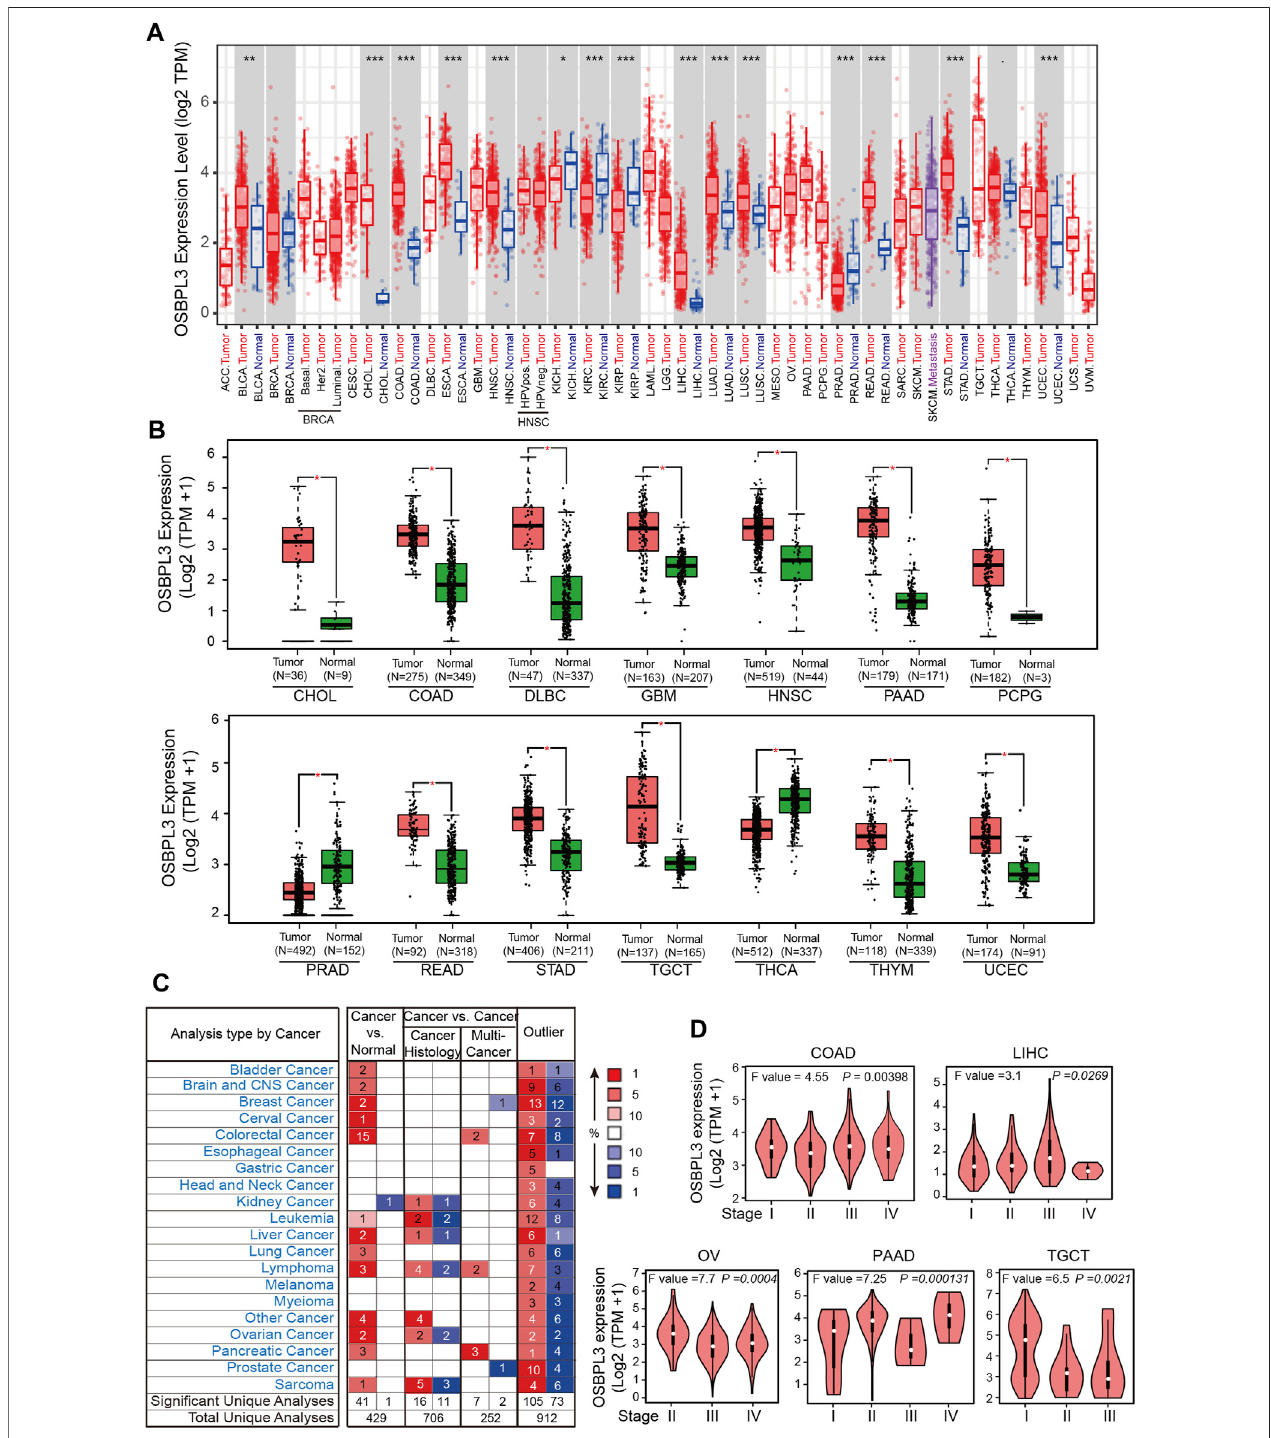
FIGURE 1 | Expression level of the OSBPL3 gene in different tumors and pathological stages. (A) Expression status of the OSBPL3 gene across diverse cancers from the TCGA dataset in TIMER. (B) Expression of OSBPL3 in the cancers from the TCGA project and the corresponding normal tissues from the GTEx database of CHOL, COAD, DLBC, GBM, HNSC, PAAD, PCPG, PRAD, READ, STAD, TGCT, THCA, THYM, and UCEC. The box plot data were supplied. (C) Transcription levels of OSBPL3indifferenttypesofhumancancersfromOncomine.Thecellnumberrepresentsthedatasetnumberthatmeetsallofthethresholds(blue:downregulated; red:upregulated).Thebestgenerankpercentilewasappliedfortheanalyseswithinthecell. (D) TheexpressionlevelsoftheOSBPL3genewereanalyzedbypathological stages (stages I – IV) of COAD, LIHC, OV, PAAD, and TGCT in the TCGA project. Log 2 (TPM+1) transformation was applied. * p < 0.05; ** p < 0.01; *** p < 0.001.